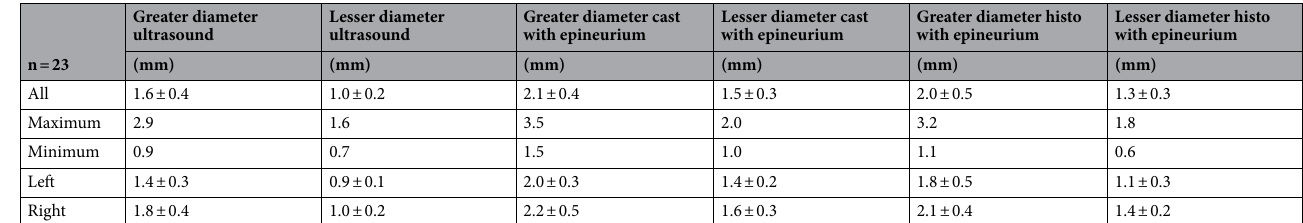
Table 1. Greater and lesser diameters of the cervical vagus nerve depend on the method of measurement. Values given in mm. Results with standard deviation. The sample size is indicated by